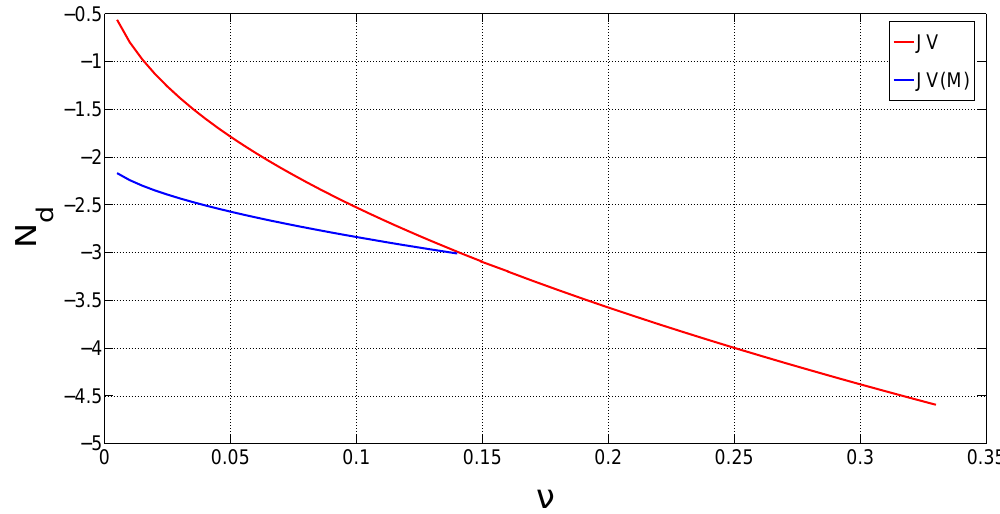
Figure 13: Missing particle number for Josephson vortices (red upper curve, labeled ‘JV’) and Josephson vortex maxima (blue lower curve, labeled ‘JV(M)’) as a function of tunneling strength with γ = 1, evaluated at the extrema of the dispersion relation ( i.e. v